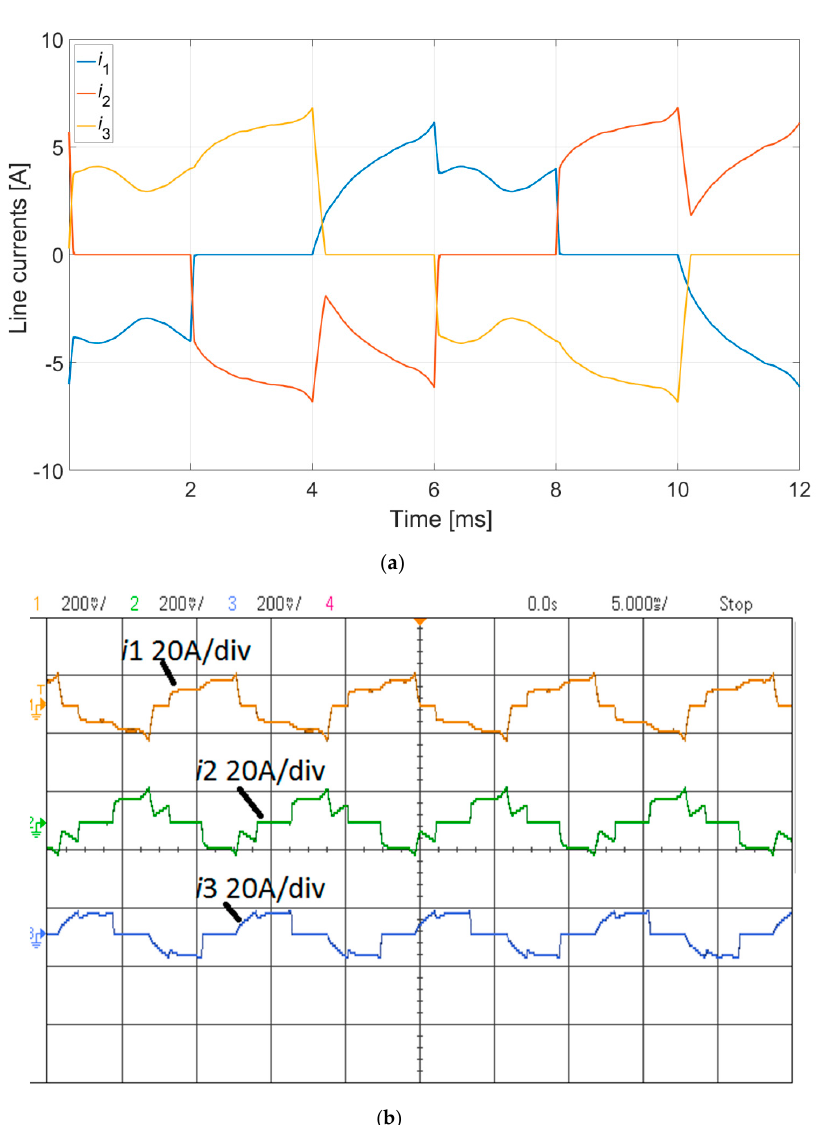
Figure 13. Delta ( Δ ) configuration—waveforms of line currents in healthy mode: ( a ) numerical calculations; ( b ) measurements.